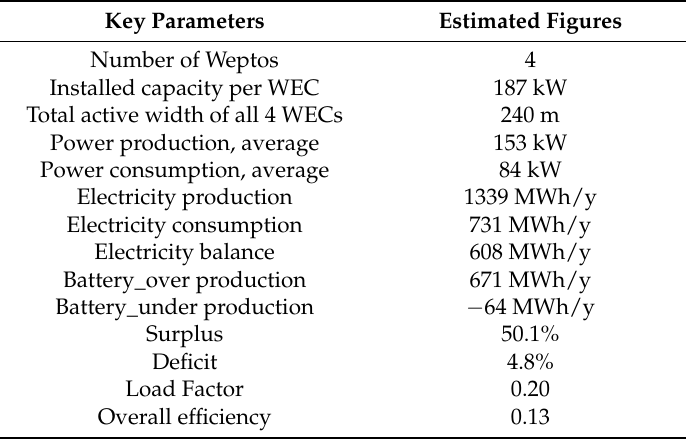
Table 5. Summary of results for 4 Weptos